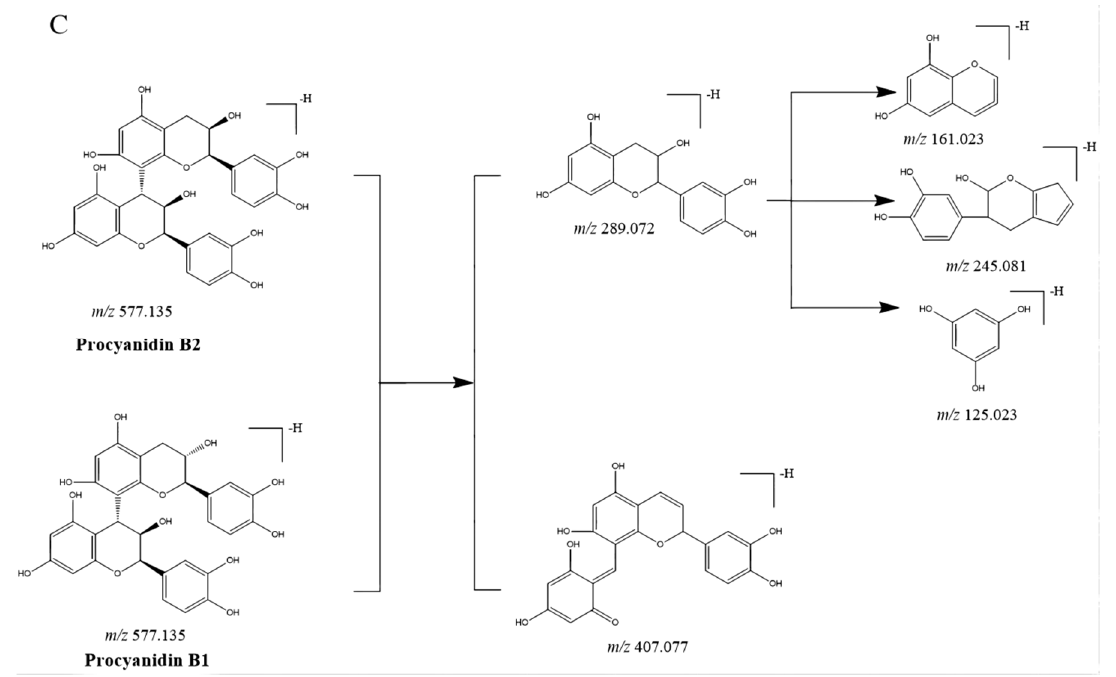
Figure 2. Proposed selected fragmentation patterns of components identified in CT: CGAs ( A ); fla- vonoids ( B ); B-type procyanidin ( C ).